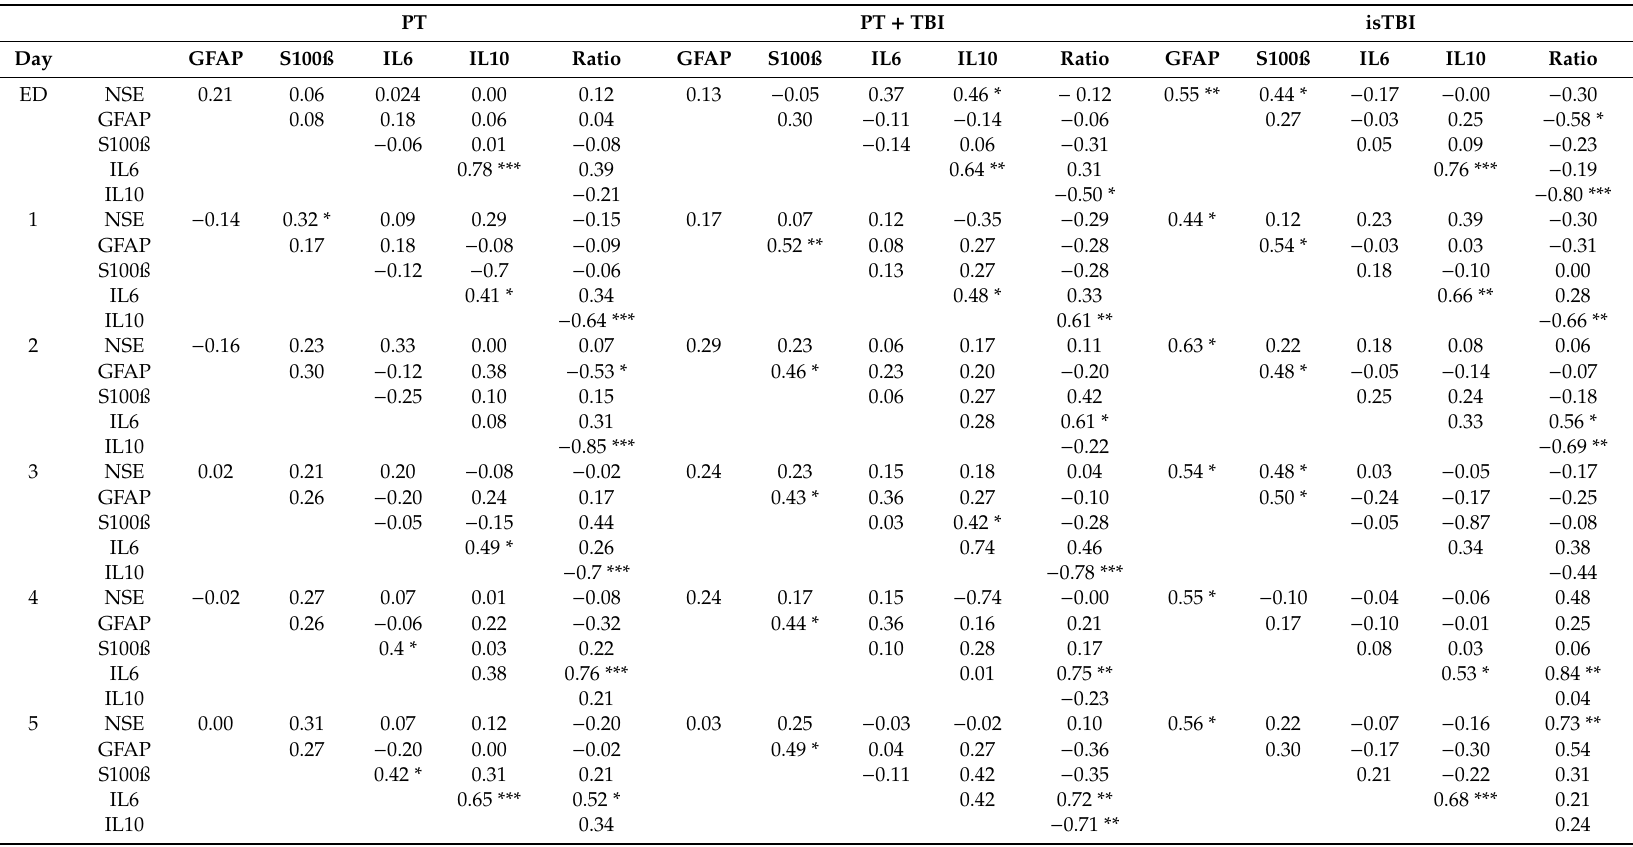
Table 2. Relation between inflammatory response and neuronal marker